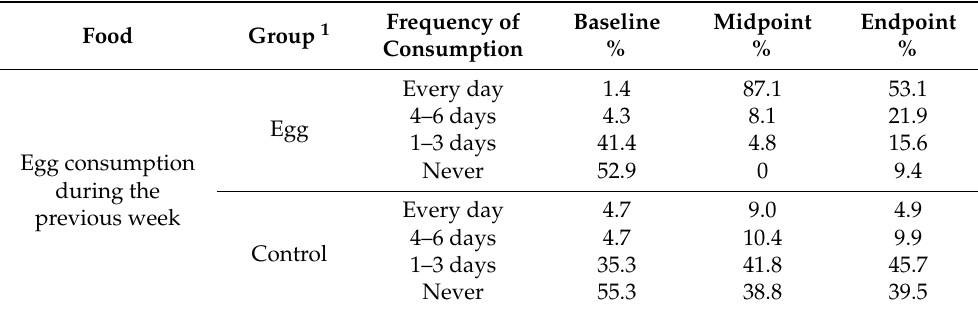
Table 6. Consumption of eggs during the preceding week, expressed as a percentage of babies for whom the food frequency questionnaire was completed.